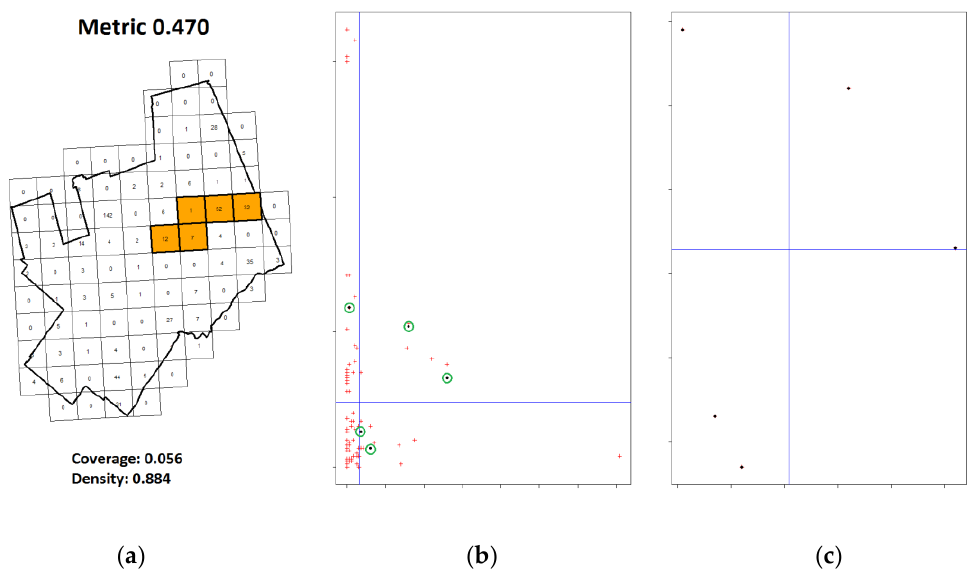
Figure 7. The most feasible study area based on the criteria of large coverage and data similarity; ( a ) optimal extent; ( b ) Moran’s I scatterplot with optimal grids circled; ( c ) Moran’s I scatterplot focused on optimal grids.